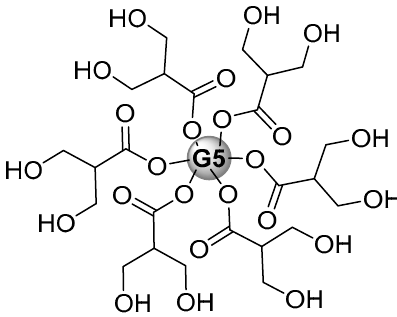
Figure 1. Biodegradable dendrimer matrix 4.